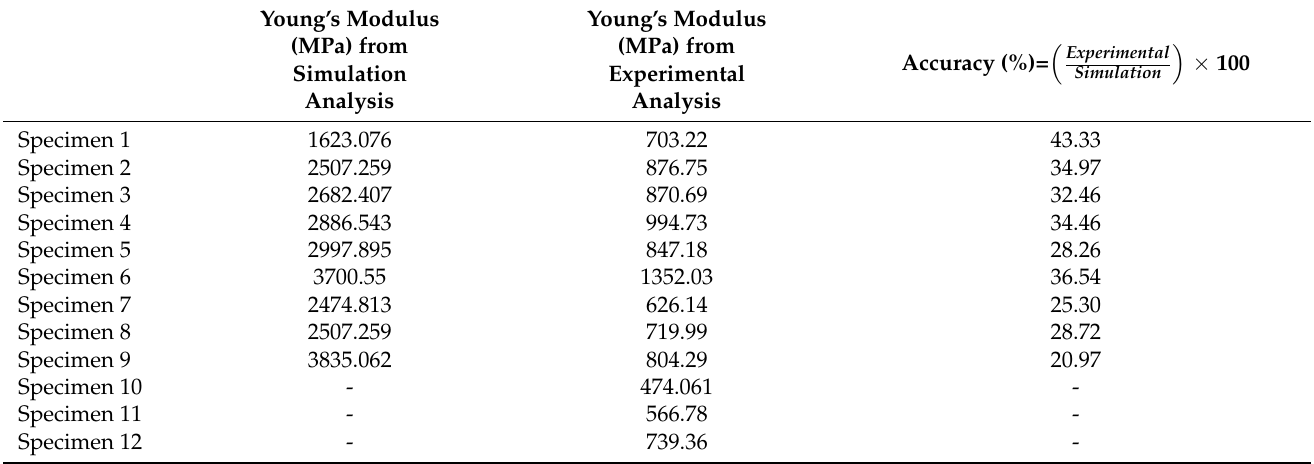
Table 5. Comparison between simulated analysis and experimental